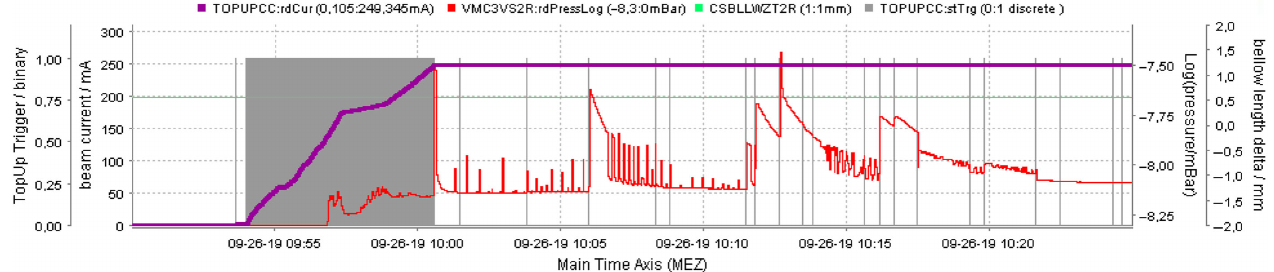
FIG. 13. Oscillatory, slowly decaying, and suddenly interrupted pressure signals observed with CSB1 (color coding like Fig. 10).